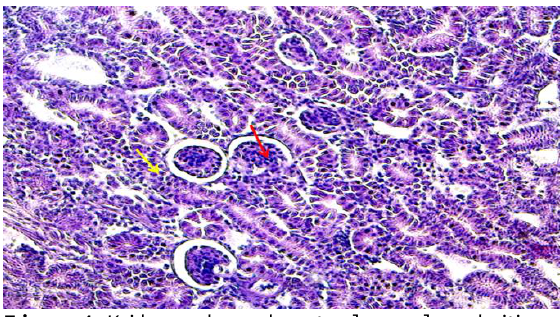
Figure,4: Kidneys showed acute glomerulonephritis due to degeneration changes in the glomeruli (red arrow) and also presence of inflammatory cells around renal tubules (yellow arrow) (H&E stain).